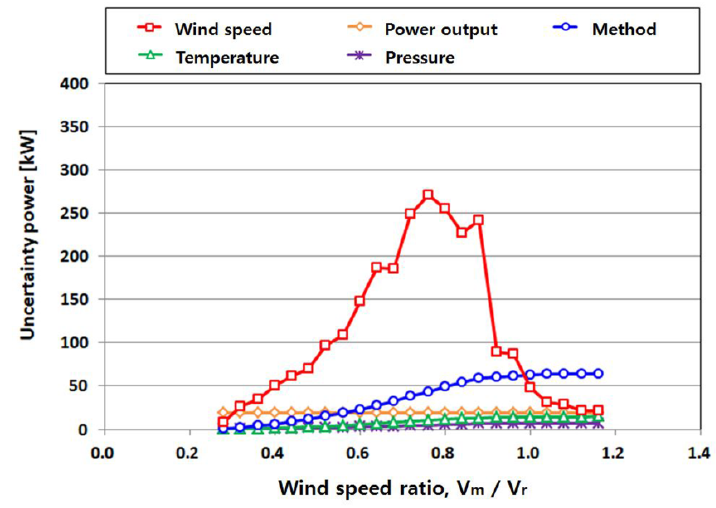
Figure 8. Uncertainties of each component in category B uncertainty for PC NTF, NL of wind turbine no. 15.